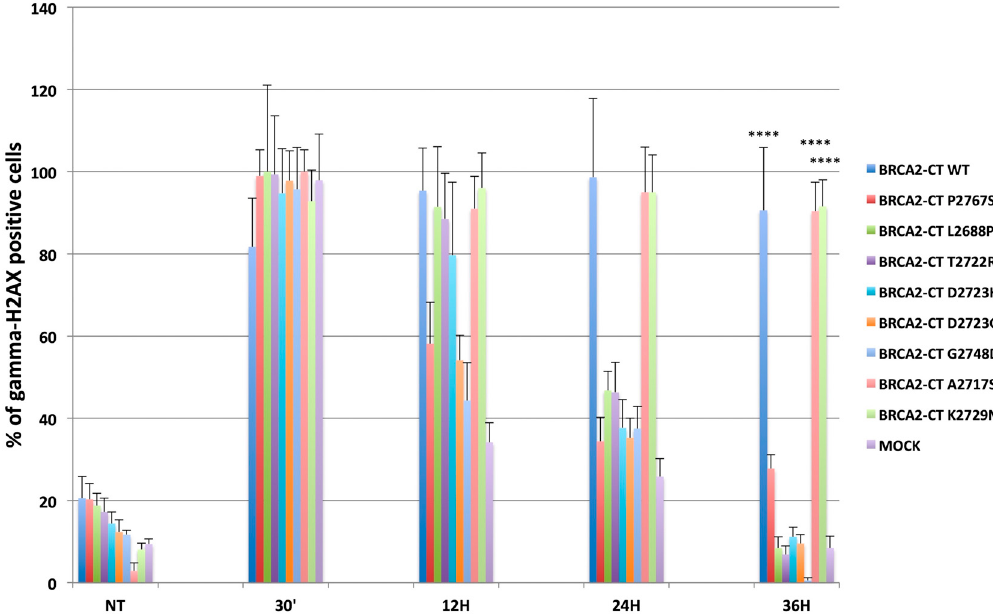
Figure 8. The DNA damage recovery assay performed on the entire variants validation set. The percentage of gamma-H2AX positive cells, before 5G γ irradiation, showed a basal level of H2AX phosphorylation for all samples. Thirty minutes after IR, each sample showed high levels of γ -H2AX that started to decrease, at di ff erent rates, until 36 h. With respect to BRCA2-CT P2767S, the DNA of the cells transfected with the BRCA2-CT WT minigene (90.6%, **** = 2.34 × 10 − 17 , p ≤ 0.0001) and the BRCA2-CT benign controls (BRCA2-CT A2717S, **** = 9.8 × 10 − 33 , p ≤ 0.0001, and BRCA2-CT K2729N, **** = 2.4 × 10 − 32 , p ≤ 0.0001) after 36 h post-IR, was not repaired, unlike in BRCA2-CT P2767S (27.76%, p ≤ 0.0001), BRCA2-CT L2688P (17.14%, **** = 1.4 × 10 − 16 , p ≤ 0.0001), BRCA2-CT T2722R (11.43%, **** = 2.74 × 10 − 16 , p ≤ 0.0001), BRCA2-CT D2723H (10,81%, **** = 6.25 × 10 − 16 , p ≤ 0.0001), BRCA2-CT D2723G (12%, **** = 1.4 × 10 − 17 , p ≤ 0.0001), BRCA2-CT G2748D (totally repaired, 0%, **** = 8.9 × 10 − 16 , p ≤ 0.0001), and the mock-transfected cells (8.47%, **** = 16.9 × 10 − 17 , p ≤ 0.0001). Instead, the decrease of γ -H2AX-positive signals in the cells transfected with BRCA2-CT P2767S and all the BRCA2-CT pathogenic controls minigenes (BRCA2-CT L2688P, BRCA2-CT T2722R, BRCA2-CT D2723H, BRCA2-CT D2723G, and BRCA2-CT G2748D) were similar to the mock-transfected cells, and differences